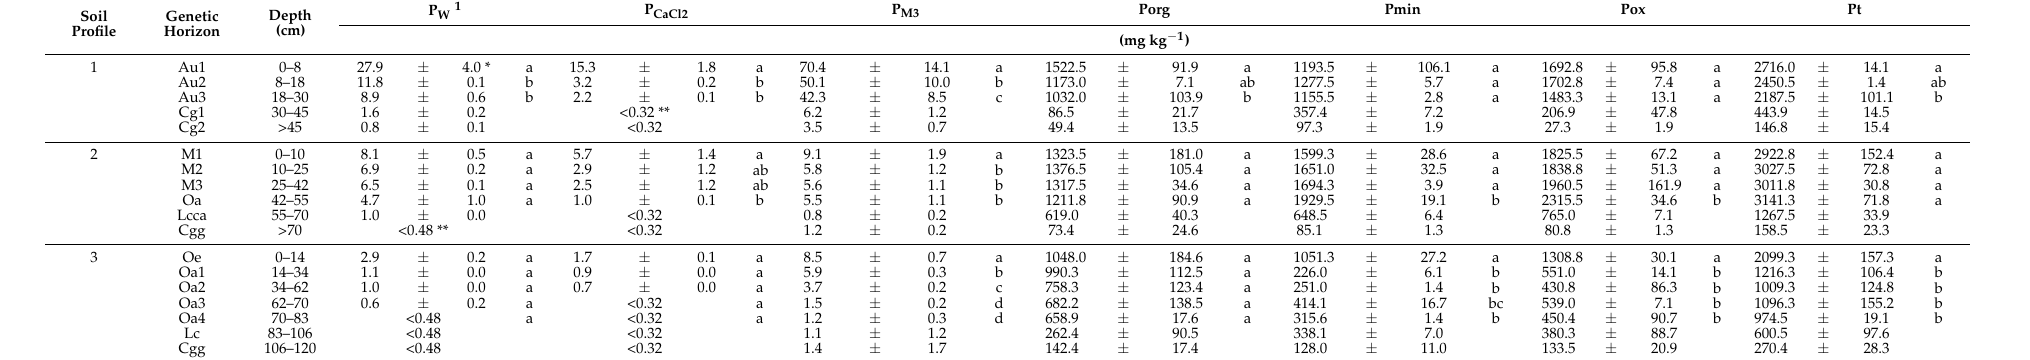
Table 5. Phosphorus forms in soils under